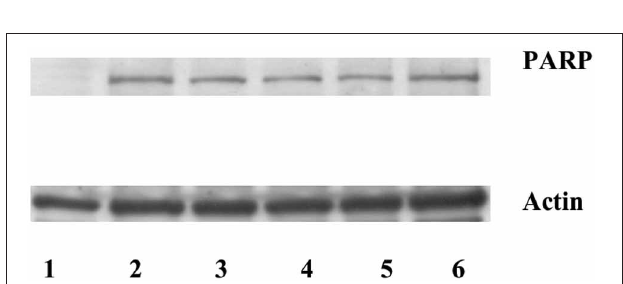
FIGURE 5 | Caspase substrate PARP cleavage was detected after STS treatment in T98G cells and T98G cells transfected with stefin B. An equal amount of proteins (70 μ g) was loaded and separated on 12,5% SDS-PAGE, followed by Western blotting with the anti-PARP antibody. Membranes were stripped and re-developed with anti-actin Ab. Track 1: control (untreated cells); track 2: T98G cells; track 3: T98G with an empty vector pcDNA3, track 4: T98G cells overexpressing stefin B into cytosol; track 5: T98G cells overexpressing stefin B into nucleus; track 6: control cells transfected with an empty pEF/myc/nucvector.